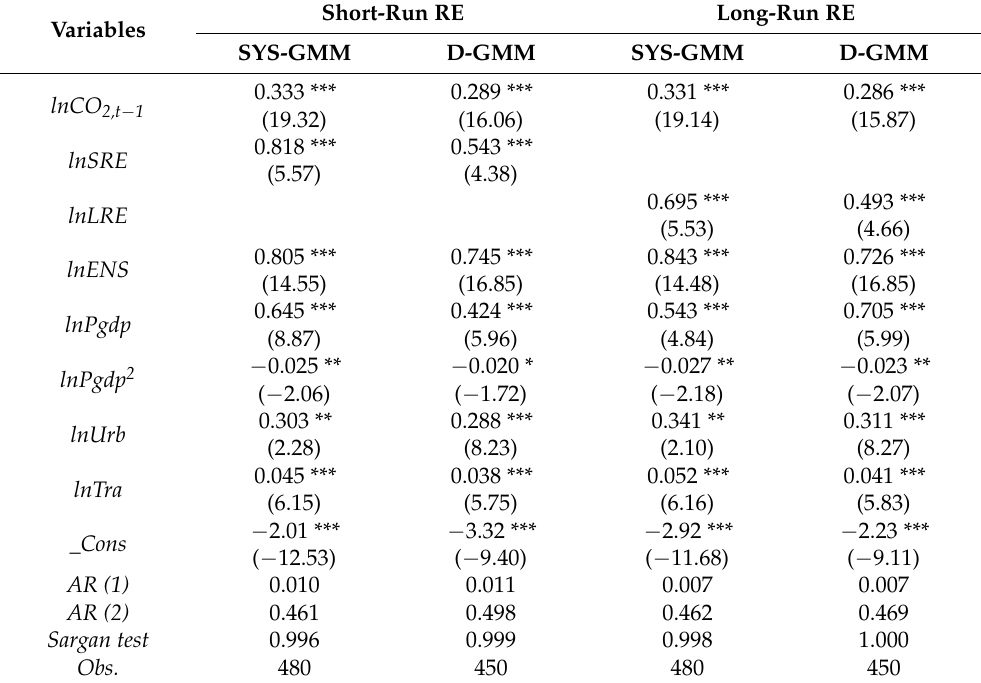
Table 5. Results of modeling the impact of RE on CO 2